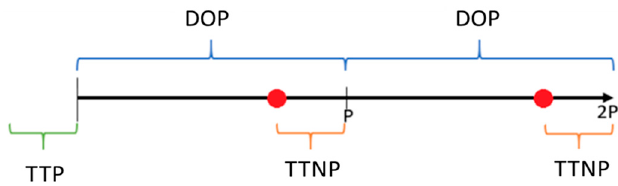
Figure 3. Timeline of the algorithm for processing data and starting point.